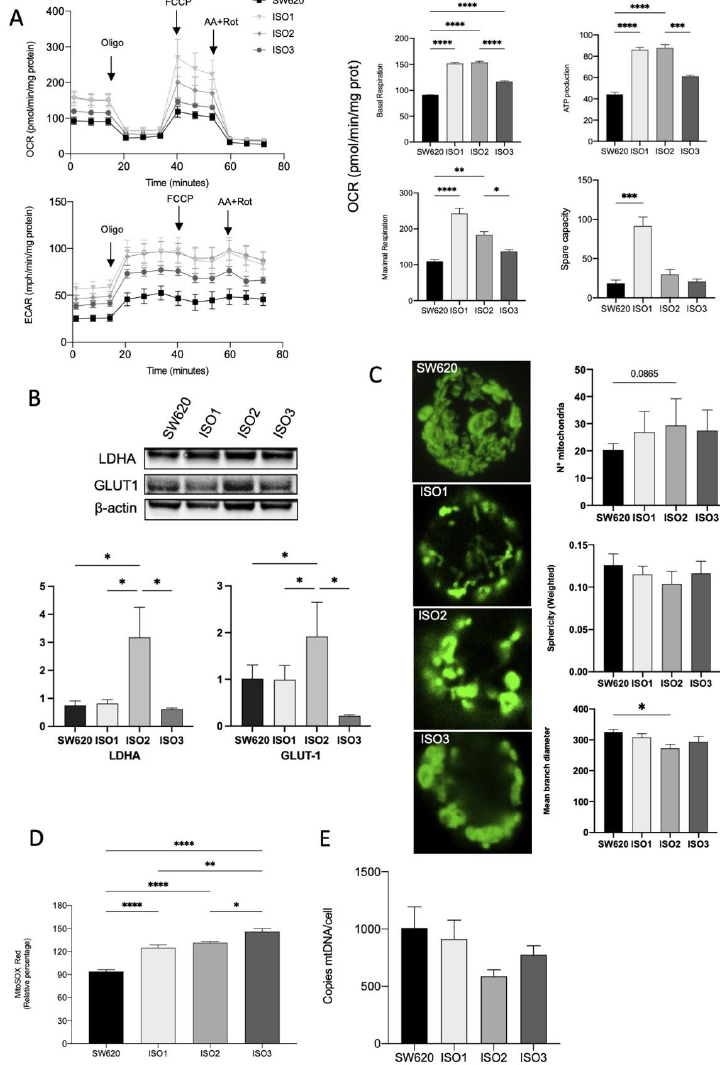
Figure 3. Effects of Lonp1 isoform-1, isoform-2, and isoform-3 overexpression on mitochondrial functions. ( A ). Seahorse analysis of oxygen consumption rate (OCR) and extracellular acidification rate (ECAR) in SW620 and cells overexpressing Lonp1-ISO1, Lonp1-ISO2, or Lonp1-ISO3 (on the left). Histograms showing single parameters of OCR, basal respiration, ATP production, maximal respiration, and spare capacity in the same cell lines (on the right). Data are reported as mean ± SD of three independent experiments. ( B ). Representative immunoblots showing LDHA and GLUT1 expression in SW620 and cells overexpressing Lonp1 isoform-1, isoform-2, and isoform-3 (upper panel). Histograms showing the relative expression of LDHA and GLUT1 in the same cell lines (lower panel). Data are reported as mean ± SD of three independent experiments. ( C ). Representative confocal microscopy images of mitochondria in SW620 and cells overexpressing Lonp1-ISO1, Lonp1- ISO2, or Lonp1-ISO3 (on the left). Mitochondria were stained with anti-hMit. Histograms showing the analysis of total number of mitochondria, sphericity, and mean branch diameter in SW620 and cells overexpressing Lonp1-ISO1, Lonp1-ISO2, or Lonp1-ISO3 calculated by FIJI (ImageJ) (on the right). Data are reported as mean ± SD of ten independent experiments. ( D ). Histogram showing ROS relative percentage in SW620 and overexpressing Lonp1-ISO1, Lonp1-ISO2, or Lonp1-ISO3. Data are reported as mean ± SD of three independent experiments. ( E ) Histogram showing the number of copies of mtDNA per cell is SW620 cells overexpressing Lonp1-ISO1, Lonp1-ISO2, or Lonp1-ISO3. Data are reported as mean ± SD of three independent experiments. * = p < 0.05; ** = p < 0.01; *** = p < 0.001; **** = p <